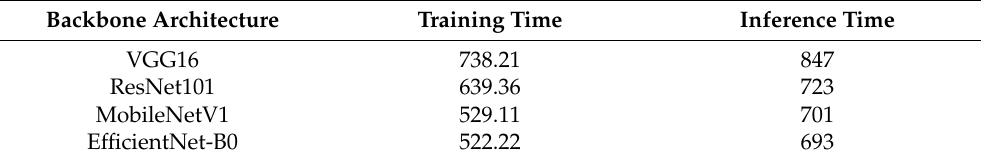
Table 6. Training time and inference time with different backbone architectures.